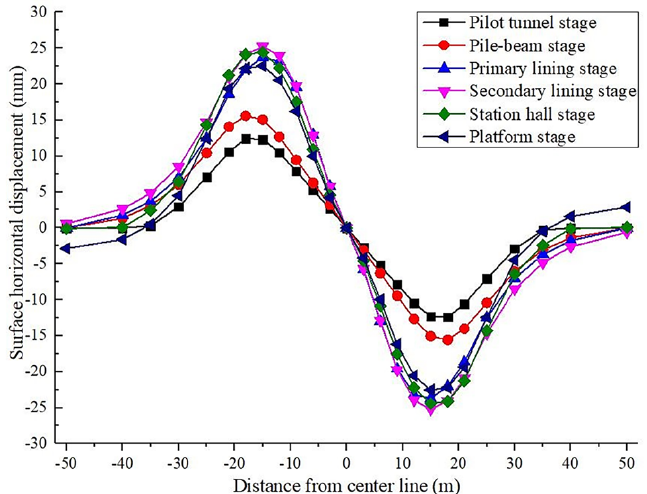
Figure 13. Horizontal displacement of station construction surface.